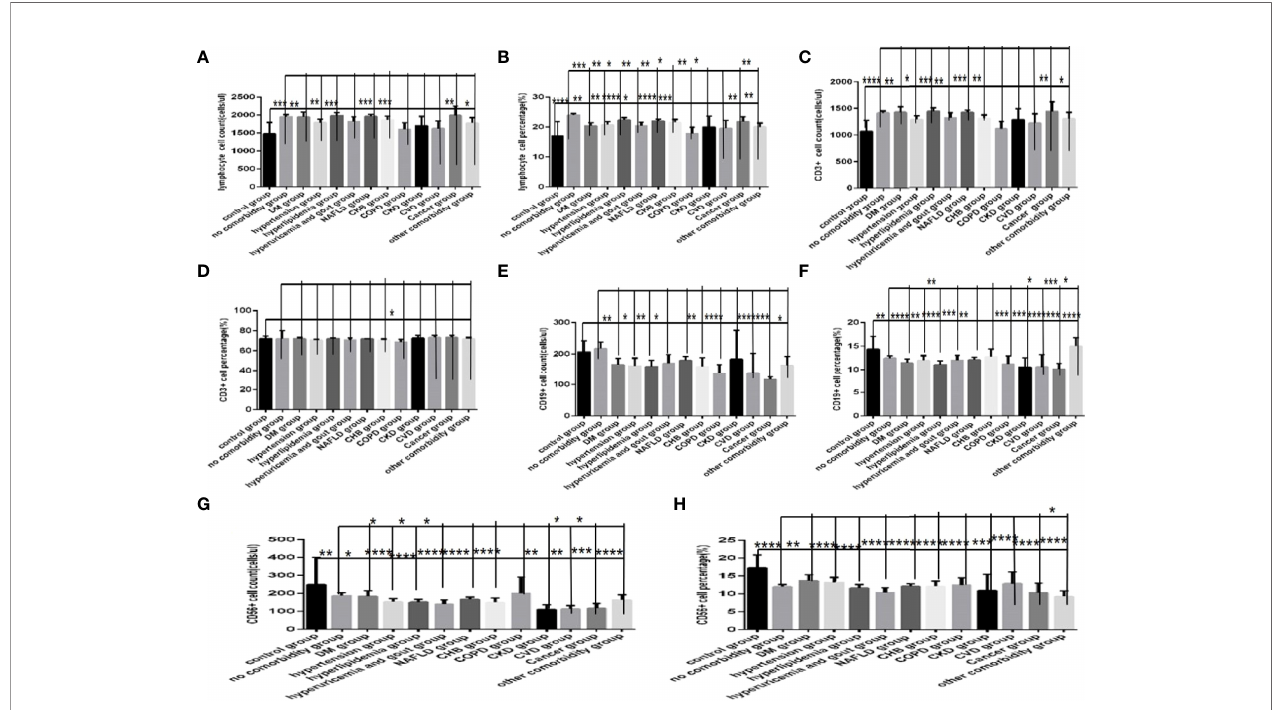
FIGURE 8 | Comparison of lymphocyte, T, B and NK cell subset counts and percentages among the control group, the no comorbidity group and each type of comorbidity group ( n =773; control, no comorbidity and each type of comorbidity group, n =55, 253, 82, 133, 47, 195, 63, 59, 15, 10, 11, 18 and 34 cases, respectively). Abbreviations: COVID-19, coronavirus disease 2019. NAFLD, nonalcoholic fatty liver disease. DM, diabetes mellitus. CHB, chronic hepatitis (B) COPD, chronic obstructive pulmonary disease. CKD, chronic kidney disease. CVD, cardiovascular disease. (A) lymphocyte count. (B) lymphocyte percentage. (C) CD3+ count. (D) CD3+ percentage. (E) CD19+ count. (F) CD19+ percentage. (G) CD56+ count. (H) CD56+ percentage. Unpaired one-way ANOVA was used for intergroup comparisons ( B, E, F, G, H , P all < 0.0001; A, C , P all < 0.05; D , P > 0.05). Unpaired t -tests were used for comparisons with the control group, and with the no comorbidity group, * P < 0.05, ** P < 0.01, *** P < 0.001, **** P